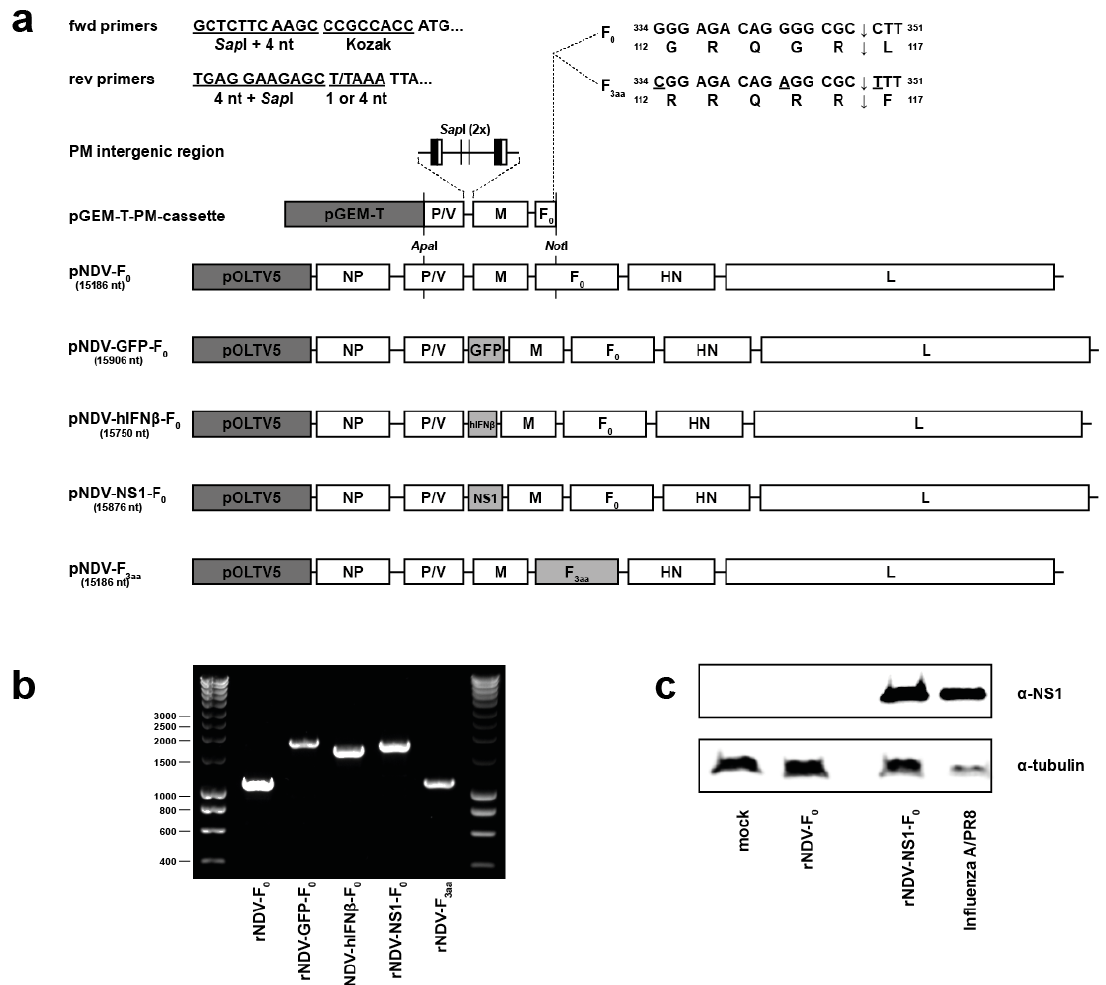
Figure 1. Generation and characterization of rNDVs. ( a ) Cloning strategy to obtain full length NDV plasmids. The nucleotide length of the NDV genome is noted below the plasmid names and all full-length plasmids and pGEM-T-PM-cassette are drawn to scale. The 3'-terminal leader, intergenic regions and 5'-terminal trailer are shown as horizontal lines. Gene-end and gene-start sequences in the PM intergenic region are depicted as vertical black and white rectangles, respectively. fwd: forward; rev: reverse; nt: nucleotides; pGEM-T: plasmid backbone of pGEM-T-PM-cassette; NP: nucleoprotein gene; P: phosphoprotein gene; V: accessory V gene; M: matrix gene; F: fusion gene; HN: hemagglutinin-neuraminidase gene; L: large protein gene; ( b ) PCR product of PM intergenic region. RNA of indicated rNDV stocks was reverse transcribed into cDNA and the PM intergenic region was amplified with RT-PCR using flanking primers; ( c ) Western blot for expression of NS1 protein. Whole cell lysates of Vero-118 cells (mock-) inoculated with indicated viruses were assayed for expression of the NS1 protein or tubulin protein.